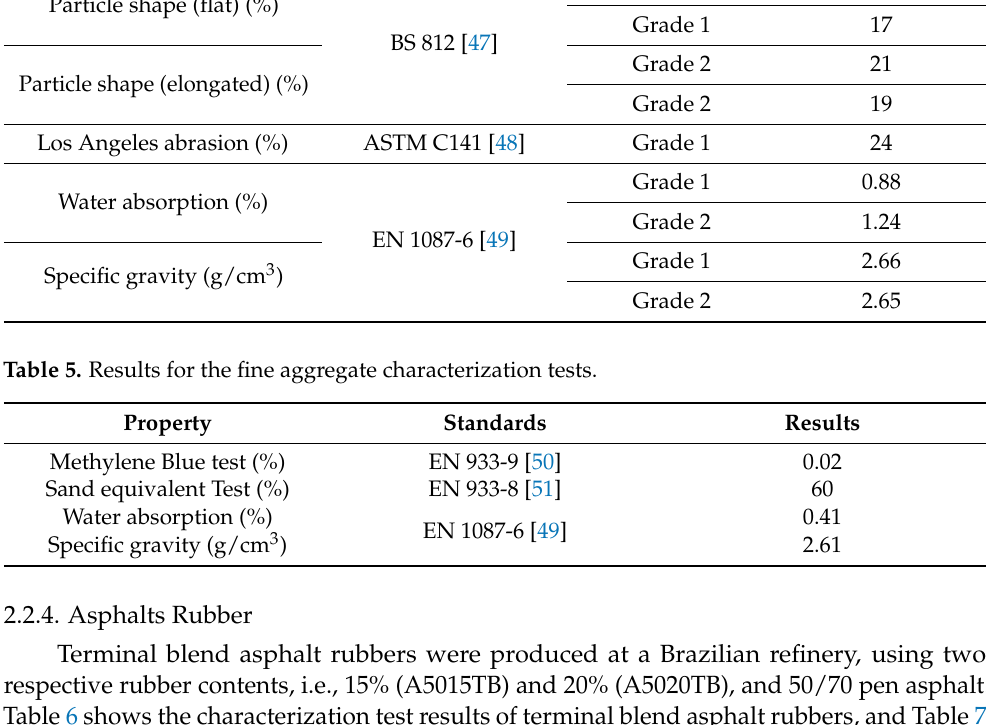
Table 5. Results for the fine aggregate characterization tests.